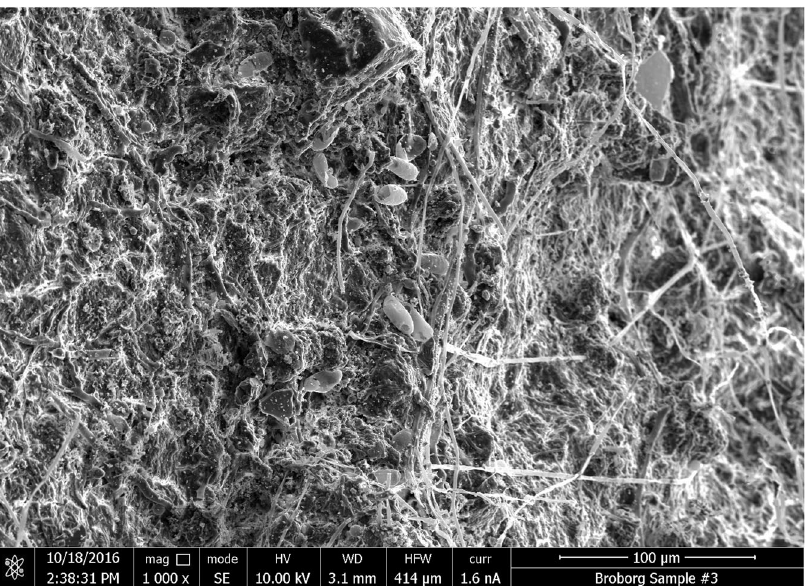
Fig. 3 Bio fi lm that has partially biomineralized on the surface on glassy material from an ancient, vitri fi ed Swedish Hillfort, Broborg. Samples 99 were analyzed with a FEI Helios NanoLab 660 (Hillsboro, OR) FIB-SEM with an energy dispersive spectrometer (EDS; EDAX Newark, NJ). An accelerating voltage of 5 kV – 10 kV, and a working distance of ~4 mm was used in the analyses of these materials. Imaging was performed with an Everhart-Thornley secondary electron (SE) detector in fi eld-free conditions, and through-the-lens detectors (TLD) for SE and back-scatter electron (BSE) imaging in immersion